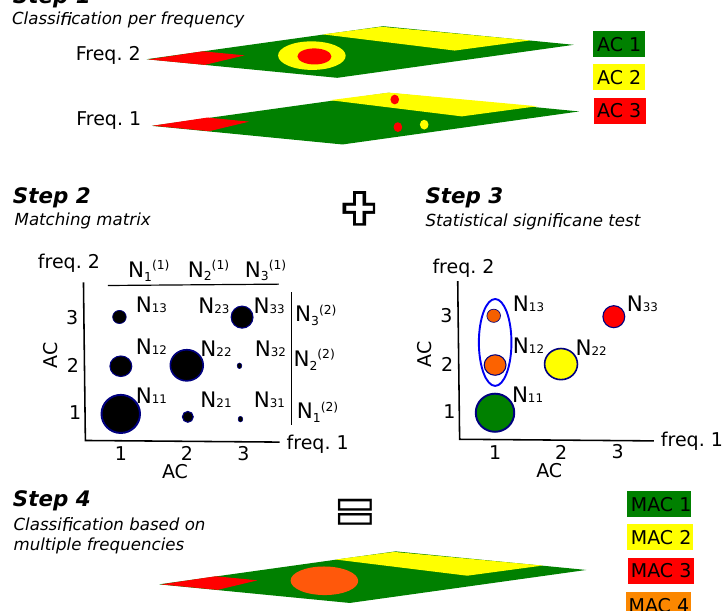
Figure 2. Sketch of the workflow for multispectral seabed classification based on the Bayesian method. Step 1 represents the application of the Bayesian method to each frequency. Here, acoustic classification maps obtained at two frequencies are shown. Step 2 shows the matching matrix for the different frequencies. Step 3 represents the results of the statistical significant test (see Equations (12) and (13)). In that example, three multispectral acoustic classes (MACs) are identified after the first part of Step 3 ( N 11 , N 22 , N 33 ) and one MAC after the second part of Step 3 ( N 12 , N 13 ). Step 4 represents the final map production based on the results of Step 3 and the assignment of the new